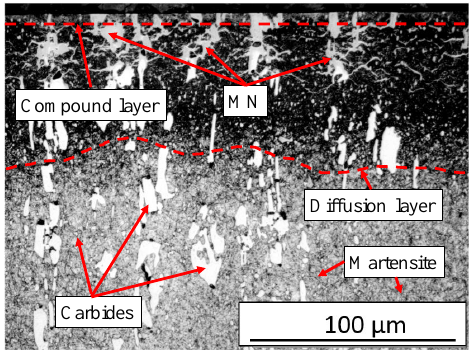
Figure 6. Assignment of the different